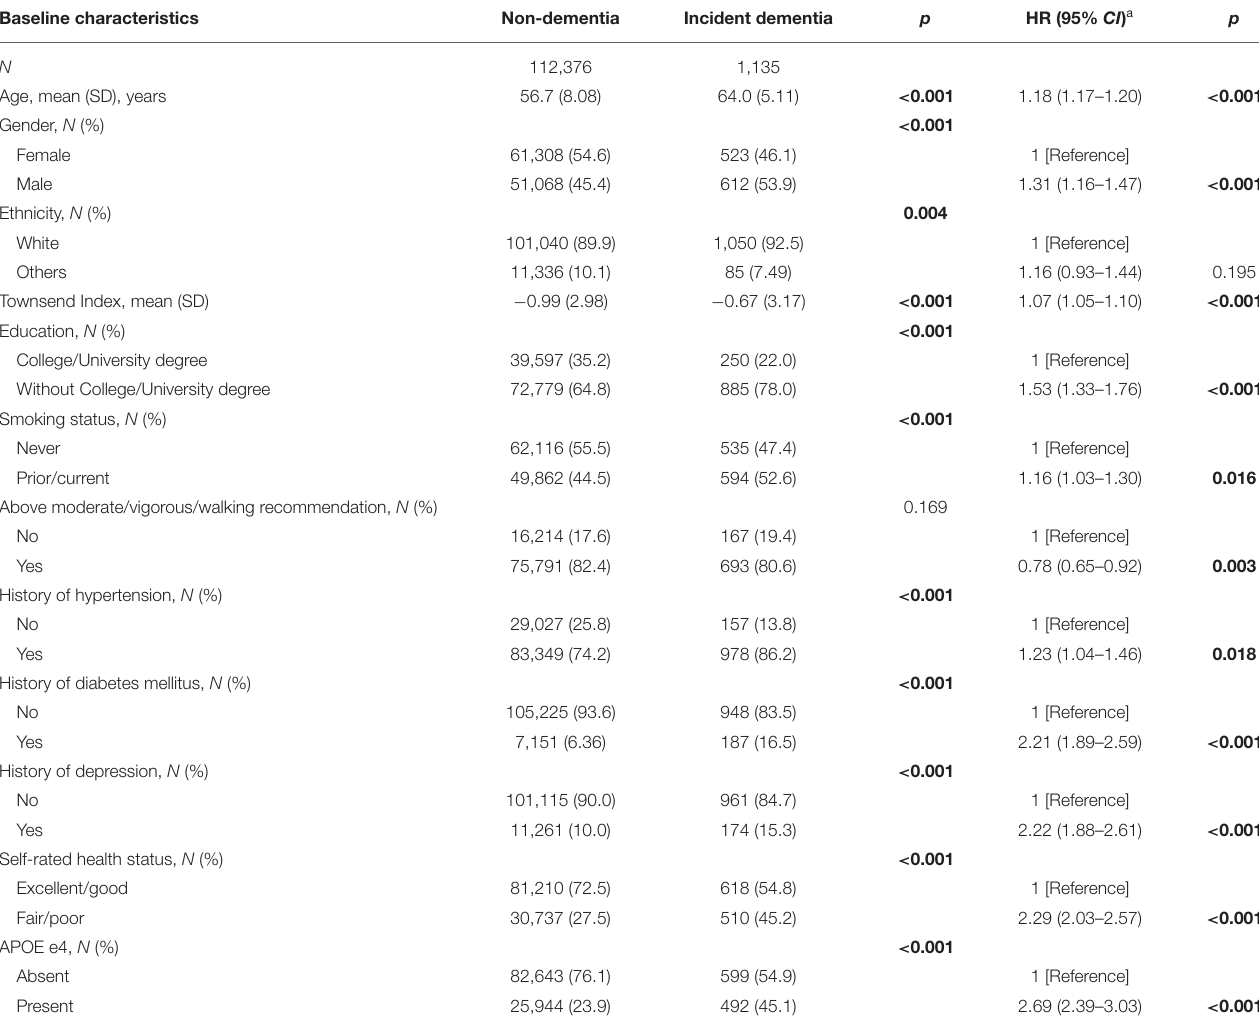
TABLE 2 | Baseline characteristics of participants stratified by incident